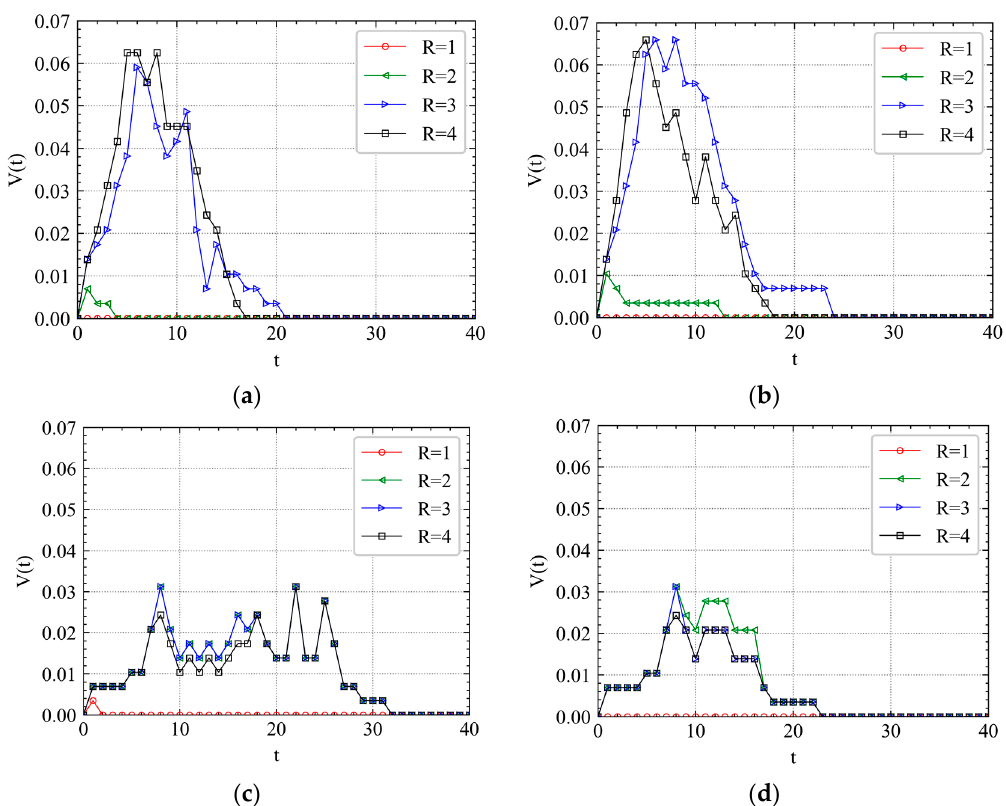
Figure 10. When the node with maximum in-flow (SRS) or maximum out-flow (XZ) is intentionally attacked, considering the heterogeneity between ε 1 and ε 2 , the cascading failure spreading speed comparison. ( a ) SRS, CMLs based on GAT, ε 1 (cid:54) = ε 2 , ( b ) SRS, CMLs, ε 1 = ε 2 = 0.25, ( c ) XZ, CMLs based on GAT, ε 1 (cid:54) = ε 2 , ( d ) XZ, CMLs, ε 1 = ε 2 =